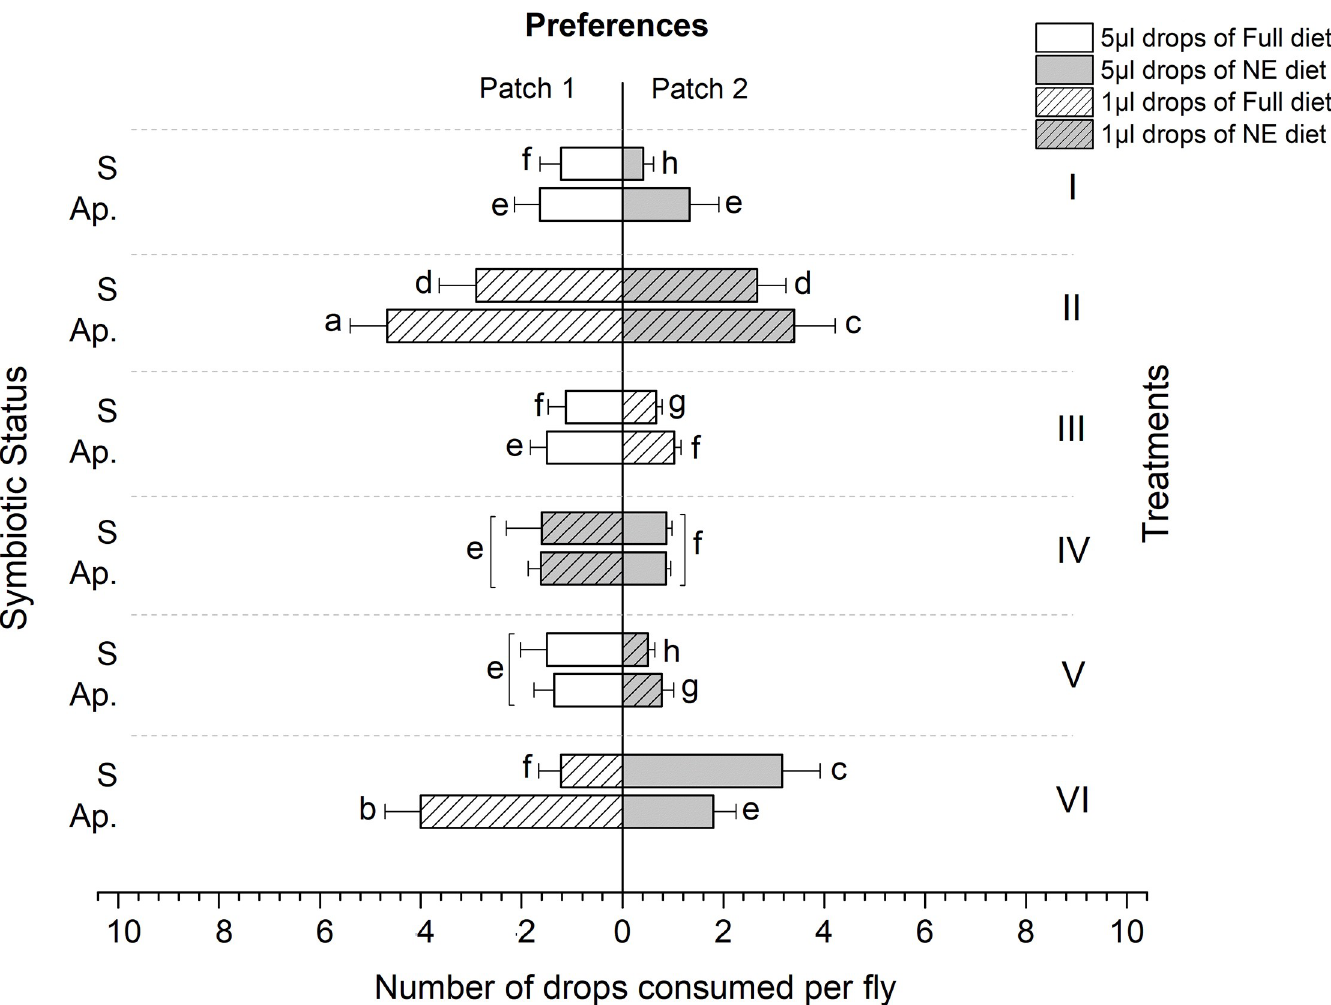
Fig 5. Number of nutritional drops consumed by symbiotic (S) and aposymbiotic (Ap.) Bactrocera dorsalis males exposed to two diet patches (full and non- essential amino acids’ diets). Each bar represents the Mean ± SE of consumed drops by each fly.